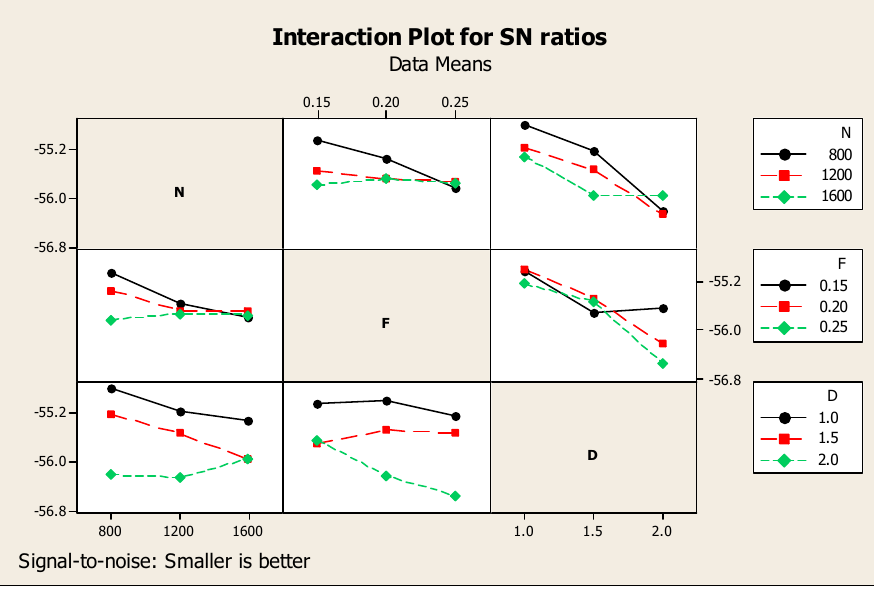
Figure 12. SR and CF-related interaction diagram. Table 8. Taguchi investigation details of MRR, SR, and CF vs. N, F, and D.